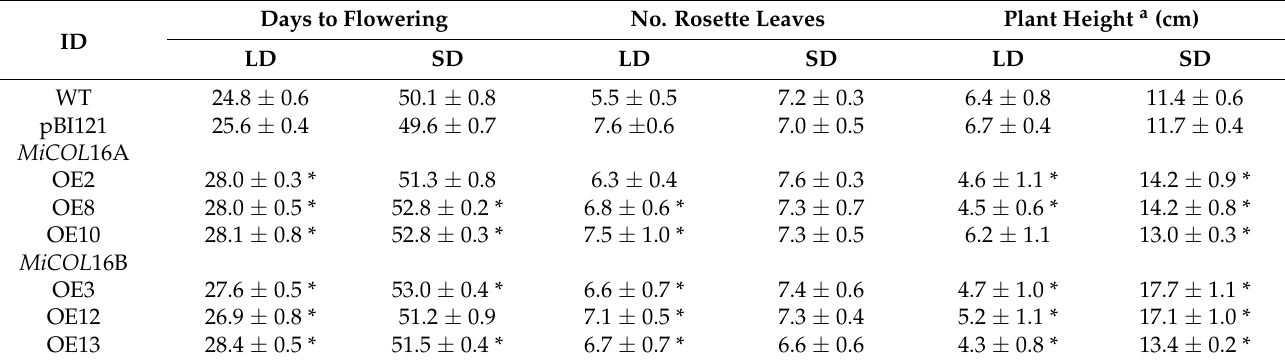
Figure 5. Ectopic expression of MiCOL16A and MiCOL16B delayed flowering under LD conditions. ( A1 , B1 ) Expression of MiCOL16A ( A1 ) and MiCOL16B ( B1 ) in the WT, empty vector-transformed and overexpression plants. ( A ) MiCOL16A transgenic Arabidopsis plants under LD conditions. ( B ) MiCOL16B transgenic Arabidopsis plants under LD conditions. Table 1. Overexpression of MiCOL16A and MiCOL16B repressed flowering in Arabidopsis